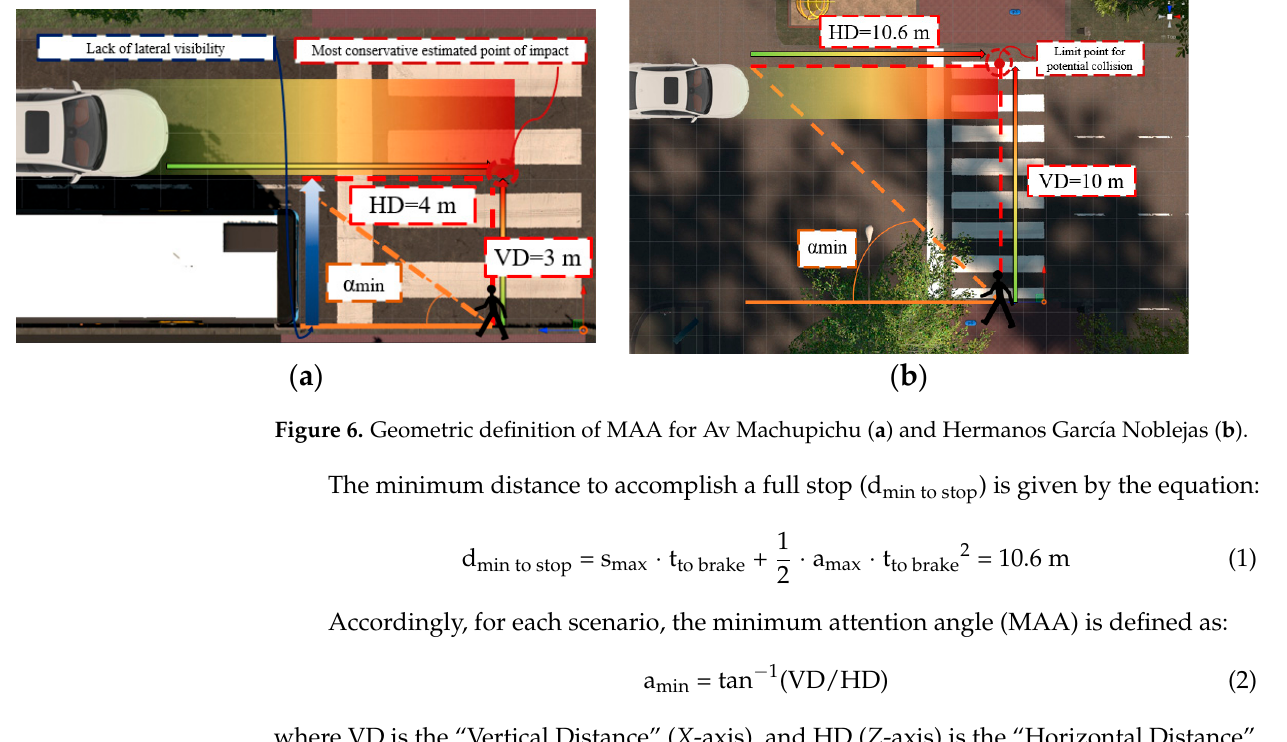
where VD is the “Vertical Distance” ( X -axis), and HD ( Z -axis) is the “Horizontal Distance”. For SC2, α = 36.9 ◦ , while in SC3 this angle takes the value α = 43.4 ◦